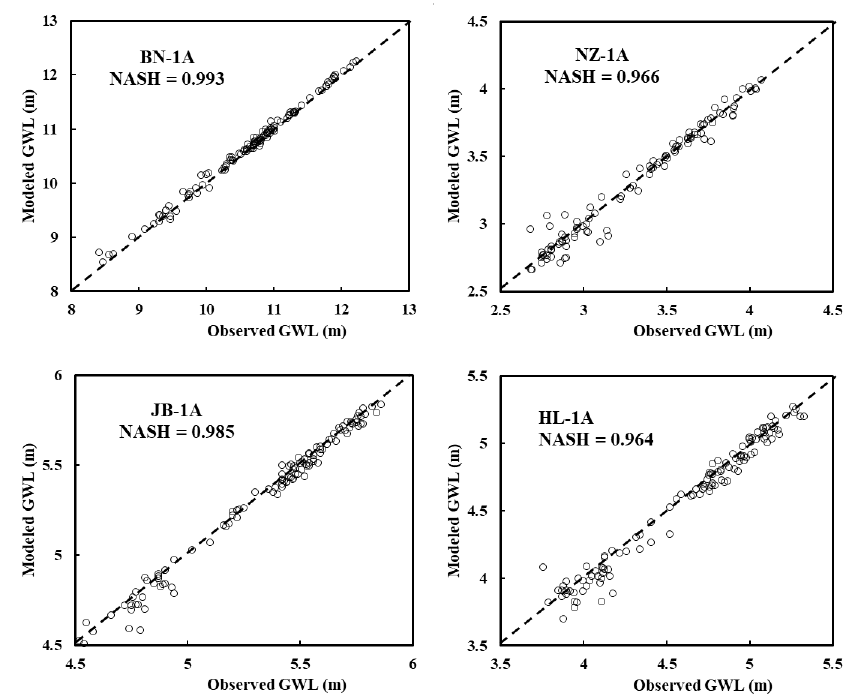
Figure 7. Modeled versus observed groundwater levels for all examined wells with respect to the perfect 1:1 match